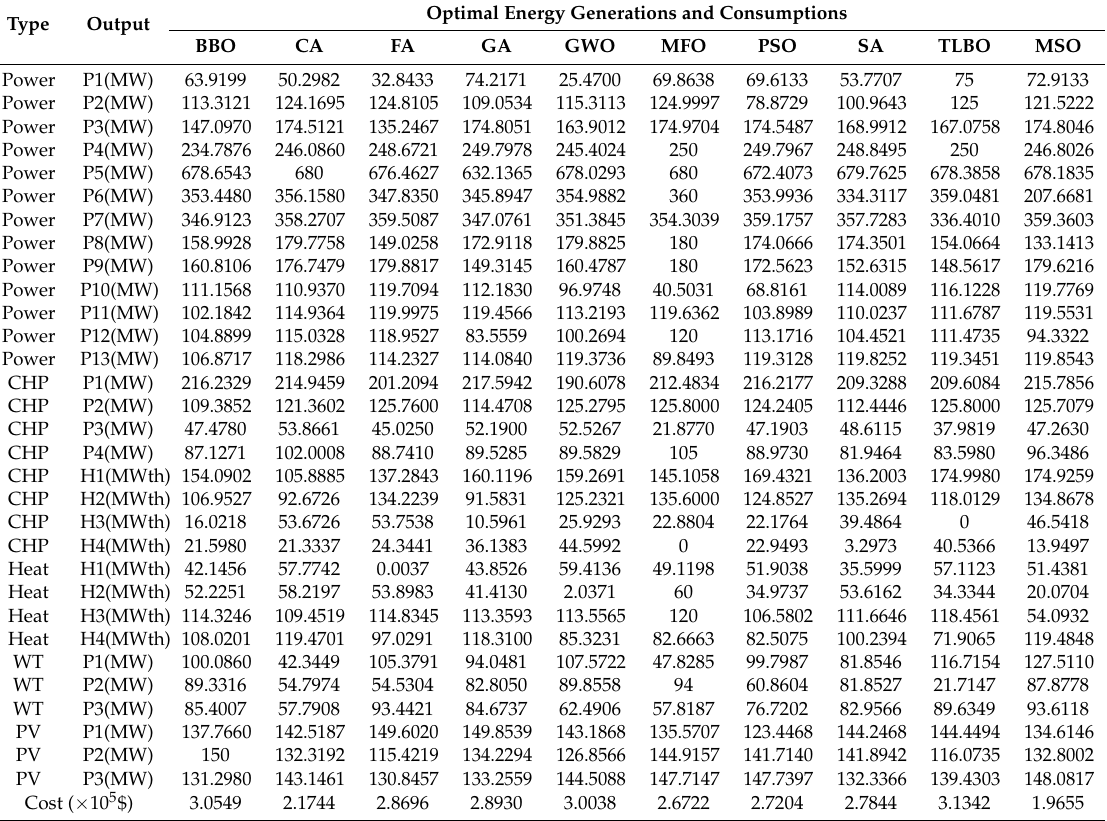
Figure 11 represents the box and whisker plots of various algorithms that were ran ten times. From the comparison of the box and whisker diagrams, it can be found that the convergence